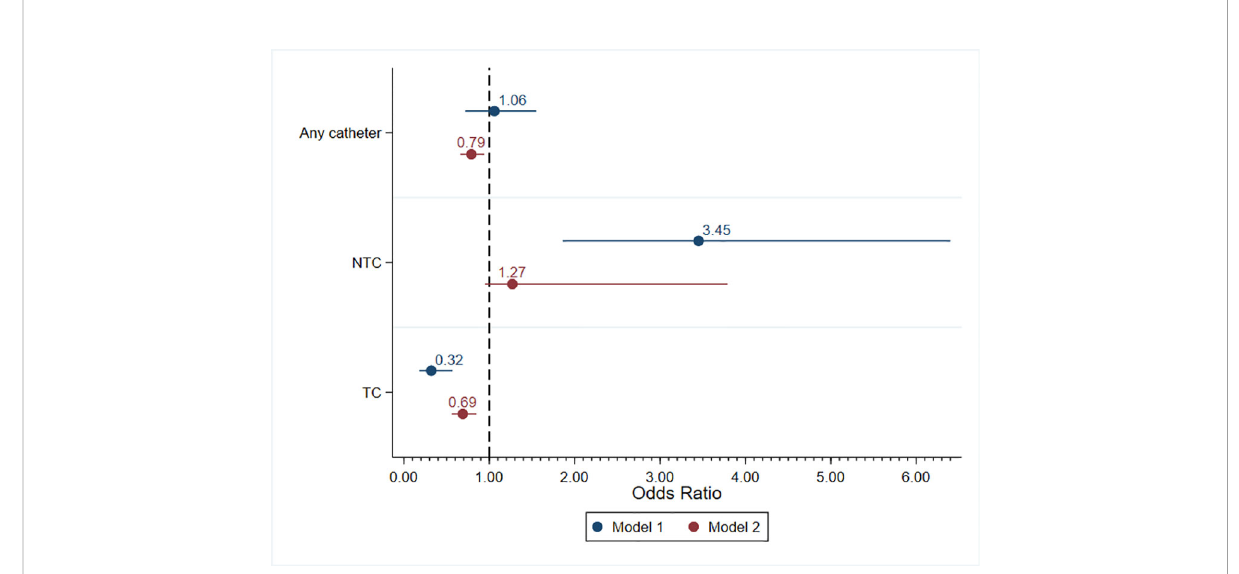
FIGURE 1 Multilevel logistic regression models for the risk of having a catheter. NTC , non-tunneled catheter; TC , tunneled